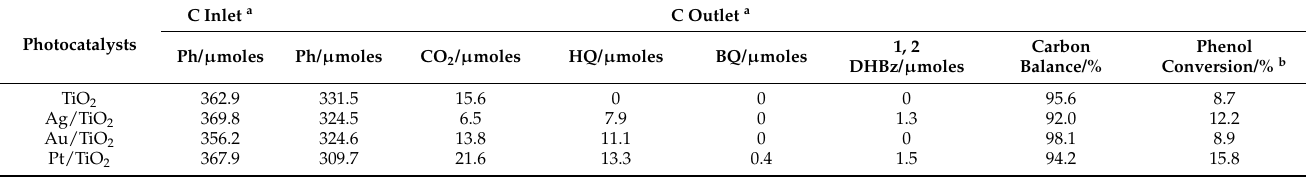
Table 2. Phenol conversion to gaseous and liquid products and carbon balance measured after 6 h of reaction time.